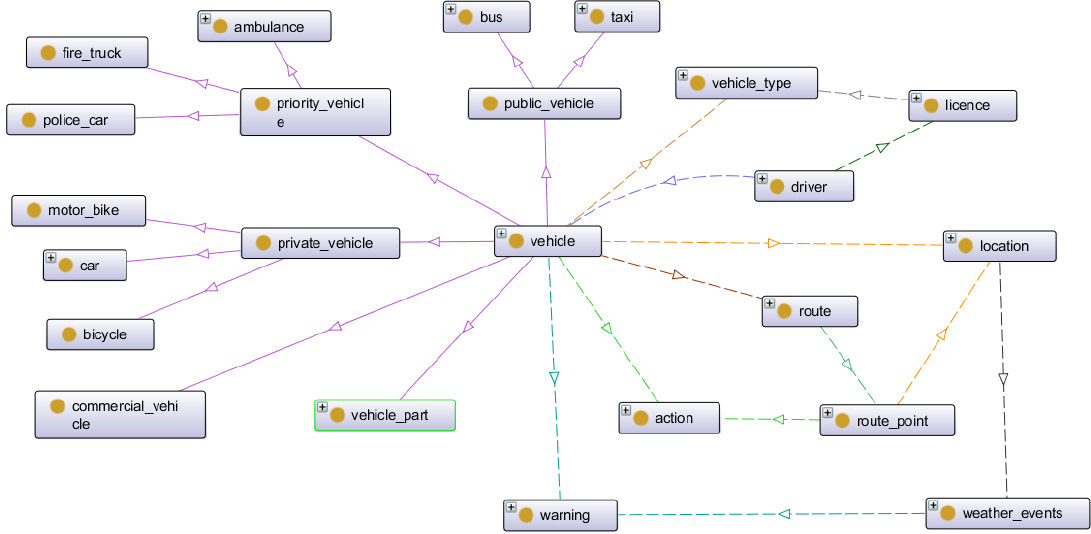
Figure 2. Concepts related to vehicles.